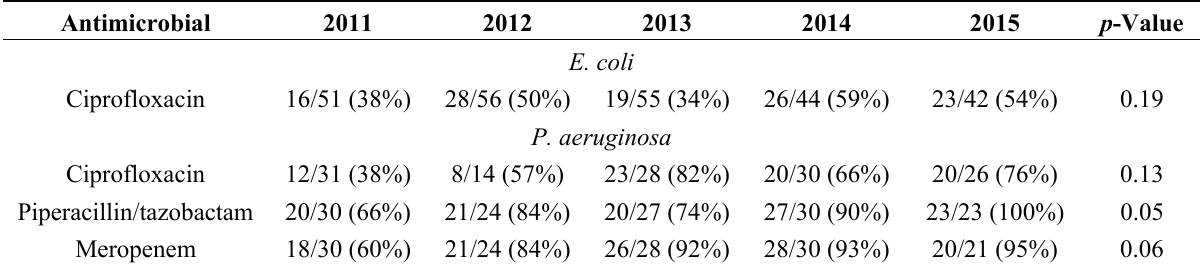
Table 6. Susceptibility rates for selected antimicrobials and organisms at hospital D by year.